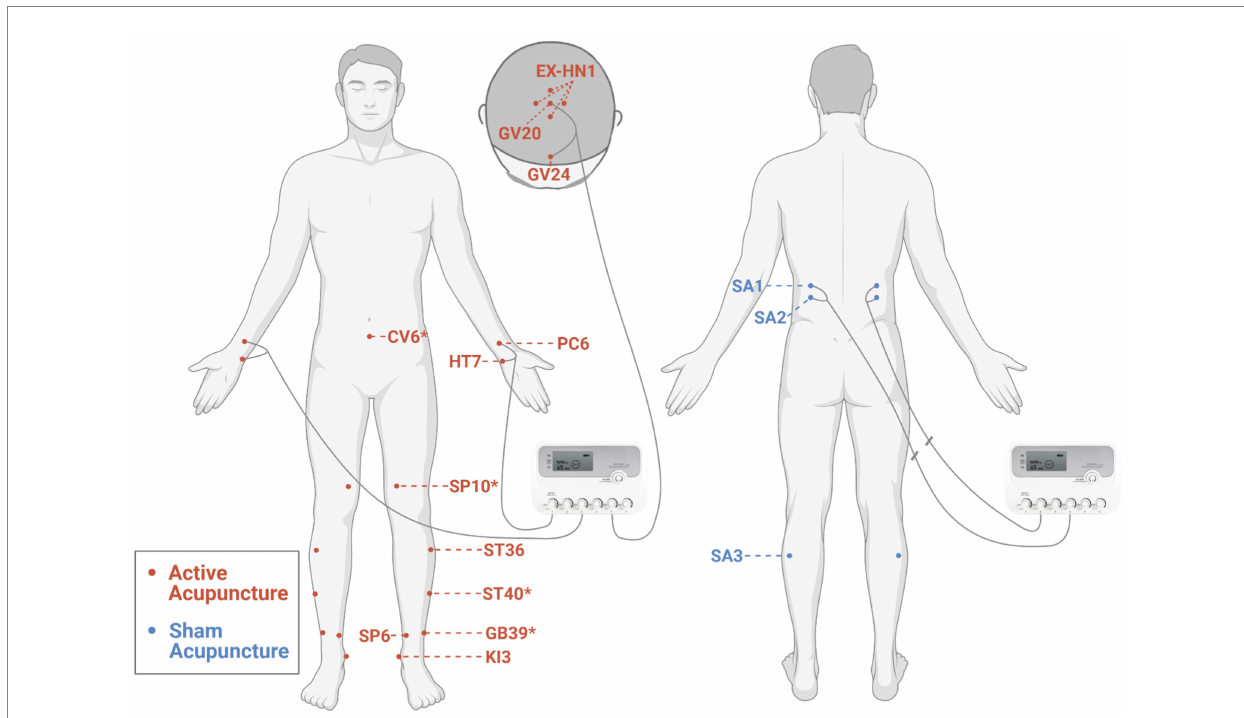
FIGURE 2 Locations of acupoints for the active and sham acupuncture. *Additional acupoints. The figure was created with